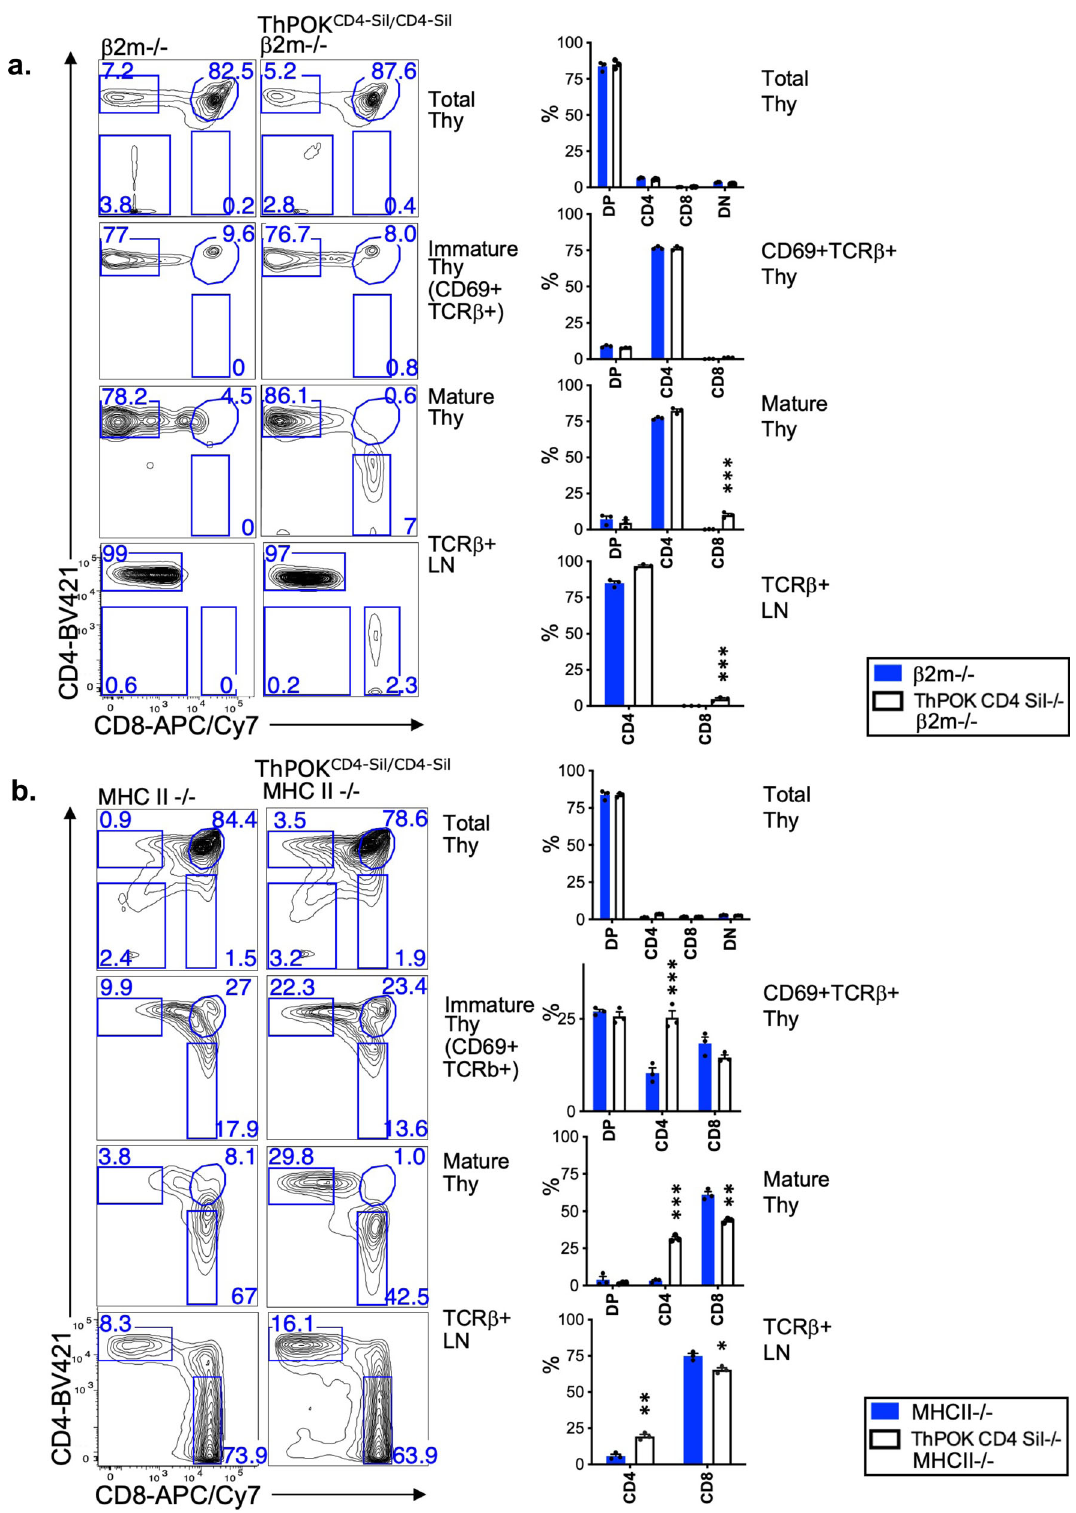
Fig. 4 Substitution of the Cd4 silencer for the ThPOK silencer perturbs the correlation between MHC restriction and lineage choice. a FACS analysis of CD4 and CD8a expression by indicated thymic or peripheral lymphocyte populations of wt or ThPOK CD4-Sil/CD4-Sil mice crossed to the β 2 m-de fi cient background. b FACS analysis of CD4 and CD8 α expression by indicated thymic or peripheral lymphocyte populations of wt or ThPOK CD4-Sil/CD4-Sil mice crossed to the MHC II-de fi cient background. N = 3 independent animals per strain. Data are presented as mean values + / − SEM. A P value < 0.05 was considered signi fi cant. Statistical signi fi cance was determined between mice of ThPOK CD4.Sil/CD4.Sil and ThPOK + / + genotypes on β 2m − / − or MHC II − / − background by one-way ANOVA with post hoc Tukey HSD, and indicated by asterisks (* P < 0.01; ** P < 0.005; *** P < 0.001). Statistical signi fi cance was calculated for each indicated mutant line relative to β 2m − / − mice ( a ), or MHC II − / − mice ( b